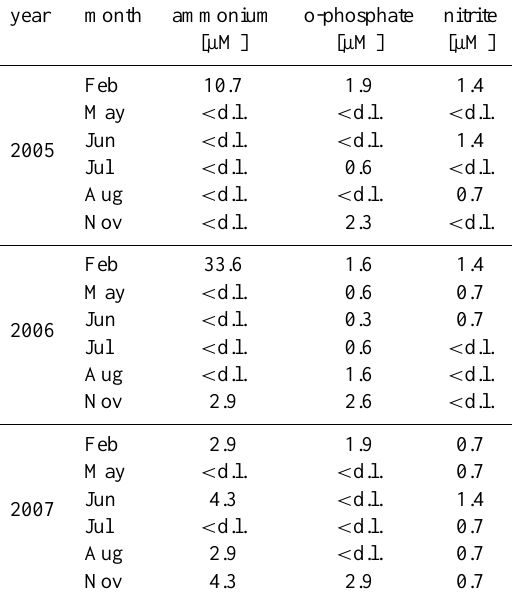
Table 5. Selected nutrient concentrations in the Elbe River at the weir of Geesthacht in the years 2005–2007, measured by the ARGE-Elbe (ARGE 2005, 2007a, b) (d.l.=detection limit , 2.8µM, 0.3µM and 0.7µM for ammonium, phosphate and nitrite, respec-